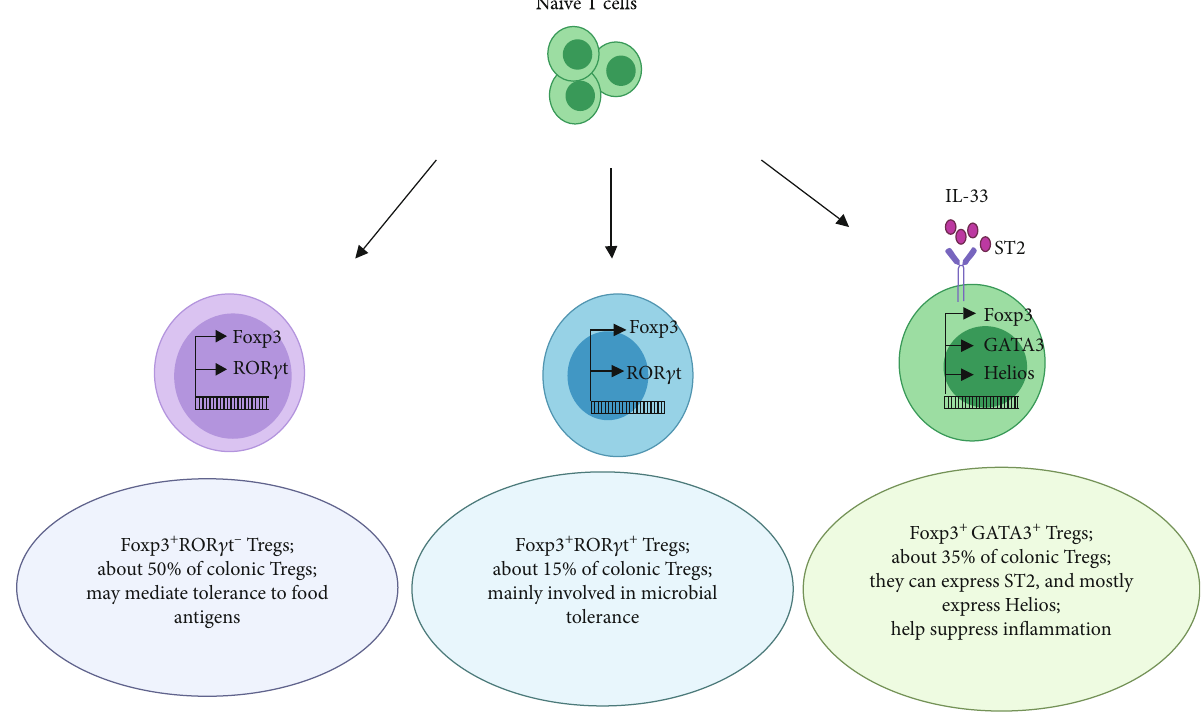
Figure 2: Classi fi cation and basic functions of colonic Tregs. Based on the expression of ROR γ t and GATA3, colonic Foxp3 + Tregs can be divided into three di ff erent subtypes of Foxp3 + ROR γ t - Tregs, Foxp3 + ROR γ t + Tregs, and Foxp3 + GATA3 +